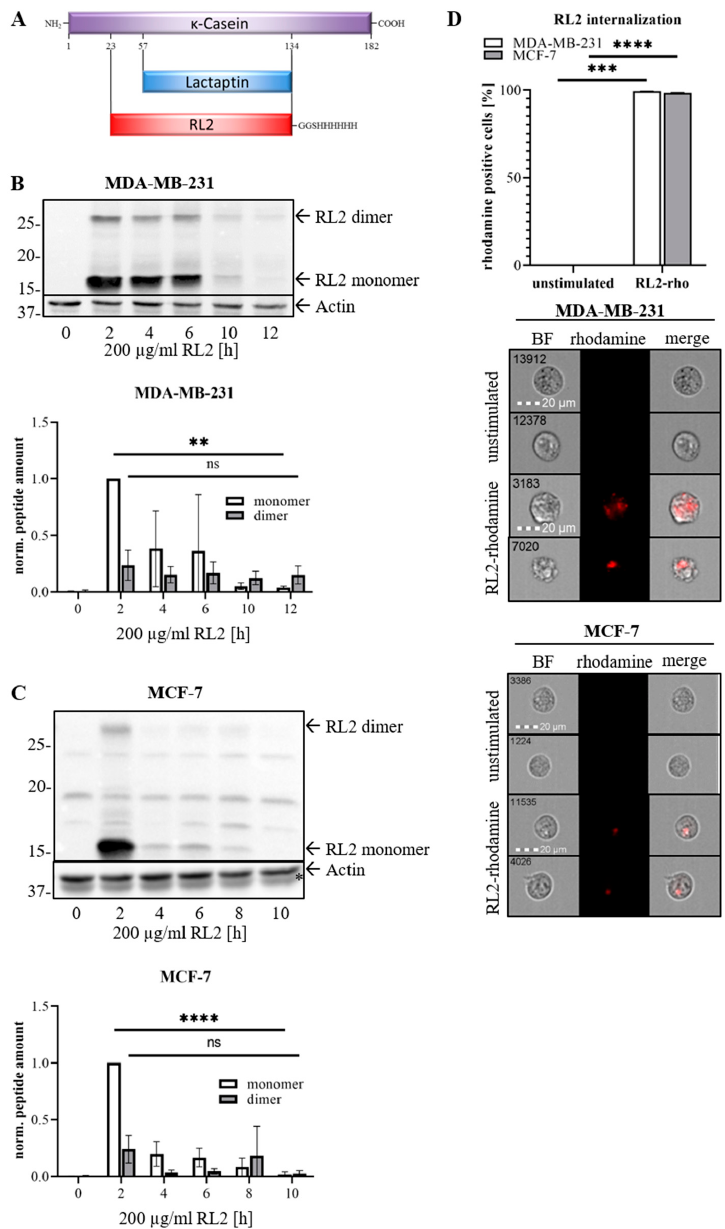
Figure 1. MDA-MB-231 and MCF-7 cells internalize RL2 and degrade it in a time dependent manner. ( A ) Scheme of RL2, Lactaptin and κ -Casein proteins. ( B ) MDA-MB-231 and ( C ) MCF-7 cells were treated with 200 µ g / mL RL2 for indicated time intervals. Extracellular RL2 was removed by washing during cell harvest. RL2 was detected in the cellular lysates by Western Blot using anti- κ -Casein antibody. One representative Western Blot out of three independent experiments is shown. Quantification was done for three independent experiments. The statistical analysis was performed by one-way ANOVA test. ( D ) MDA-MB-231 and MCF-7 cells were treated with 50 µ g / mL Rhodamine-labelled RL2 for four hours and analyzed with FlowSight ® for RL2 internalization. Bottom: At the left column single cells are shown in bright field (BF) channel, at the right column merging of Rhodamine signal and bright field image is performed for representative single cells. Top: The amount of Rhodamine-RL2 positive cells are presented from three independent experiments. The statistical analysis was performed by paired student t -test. Relative Western Blot quantifications of Figure 1B,C are shown in Figure S1. ns (not significant; p > 0.05), ** (significant; p < 0.01), *** (significant; p < 0.005), **** (significant; p <